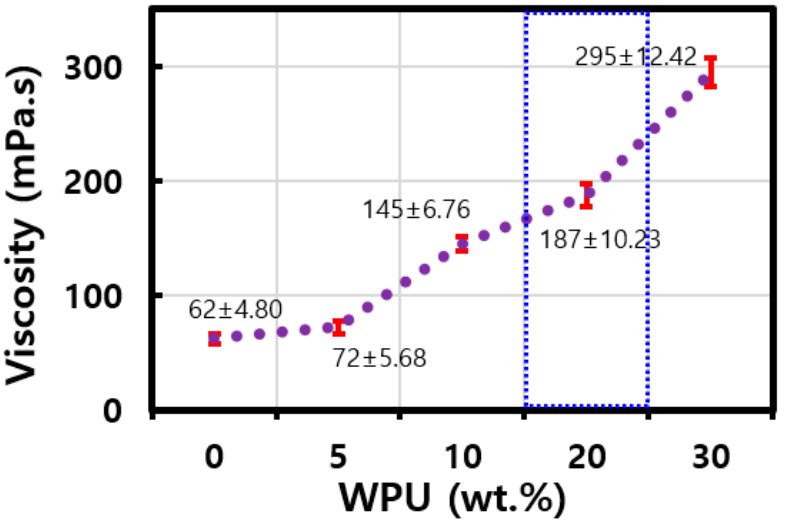
Figure 3. Viscosity according to WPU contents.